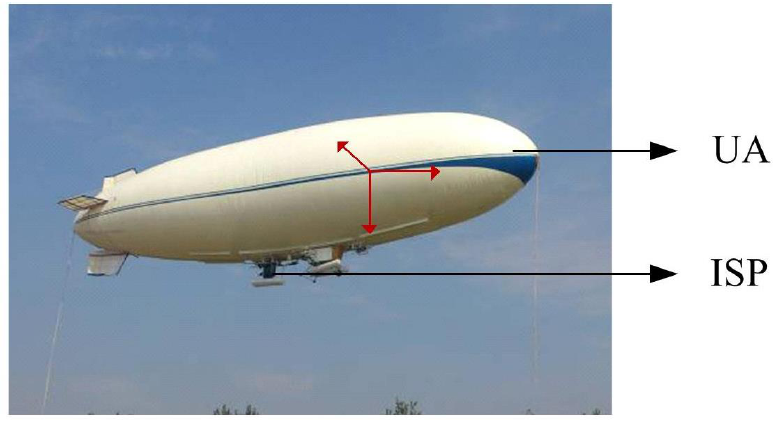
Figure 21. The experiments with a two-axis ISP system on a UA in the